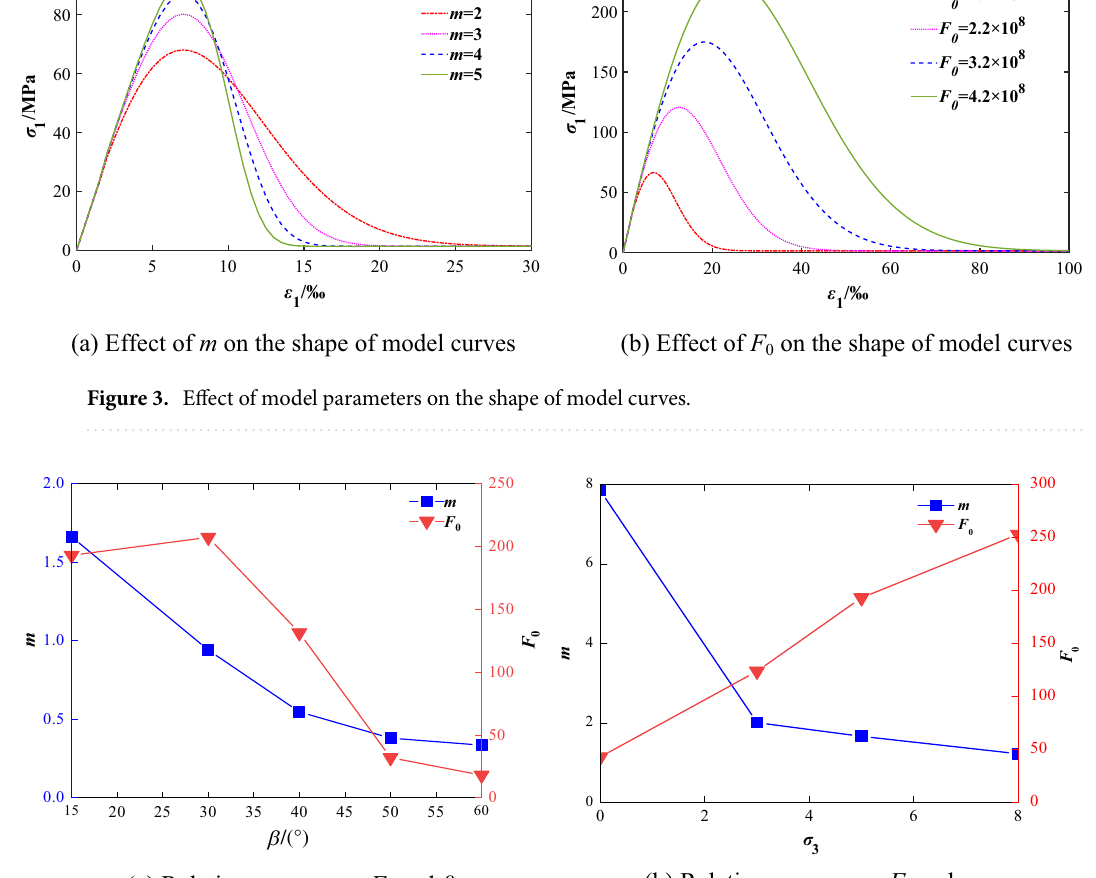
Figure 4. Effect of confining pressure and joint dip angle on model